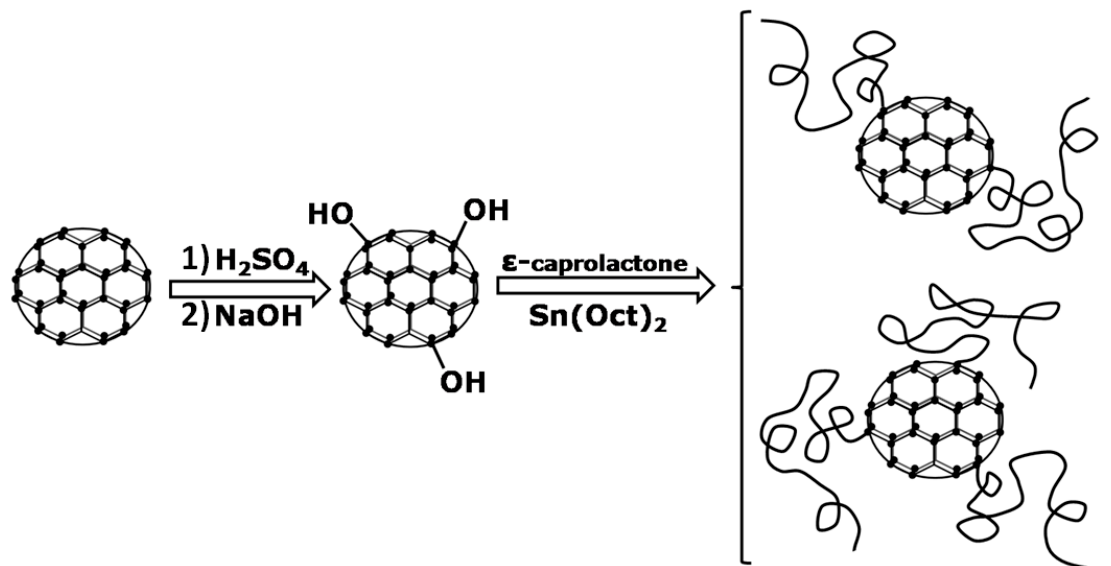
Figure 3. Schematic displaying the steps needed to obtain 2 and 3 arm